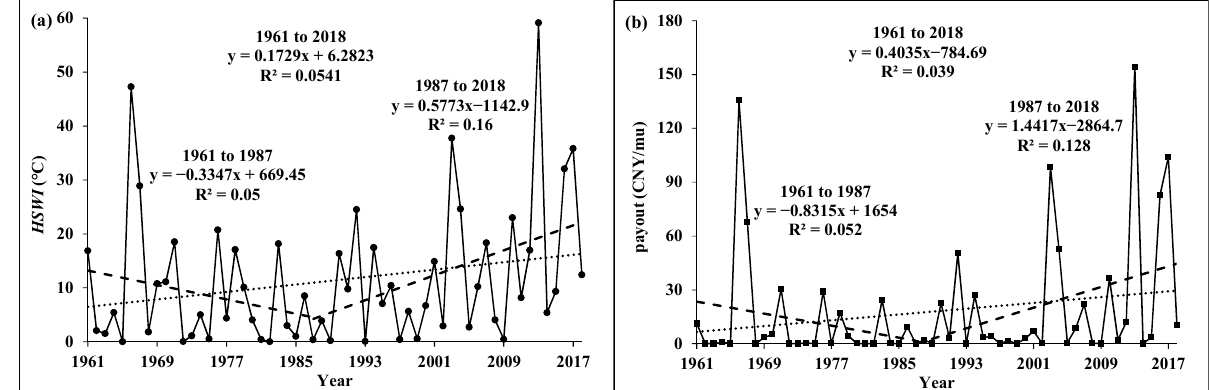
Figure 4. Annual variation in HSWI ( a ) and payout ( b ) due to rice heat stress in the area south of the Huai River in Anhui Province from 1961 to 2018. Global warming was determined to be more significant after the 1980s. From 1987 to 2018, the HSWI and the payout increased at all meteorological stations in the study area, and the variation rates ranged from 2.0 to 11.5 °C per decade and 3.0 to 31.7 CNY mu − 1 per decade, respectively. The largest increasing trend was found in the area south of the Yangtze River, followed by the middle part of the Yangtze–Huai River Basin, and the western mountain area had the smallest (Figure 5).